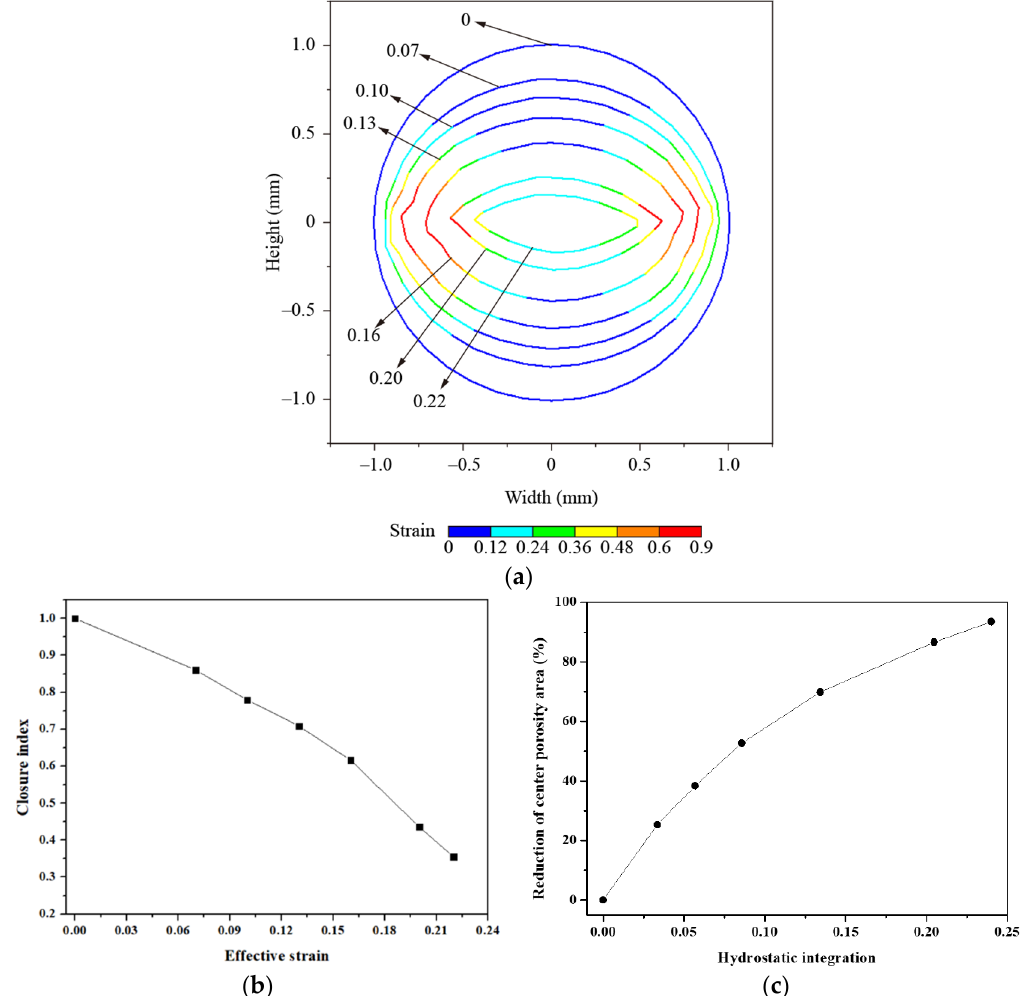
Figure 14. Closure of porosity with different reduction conditions: ( a ) analysis of morphology and equivalent strain of porosity; ( b ) closure index; ( c ) the relationship between hydrostatic integration and the reduction of porosity area.